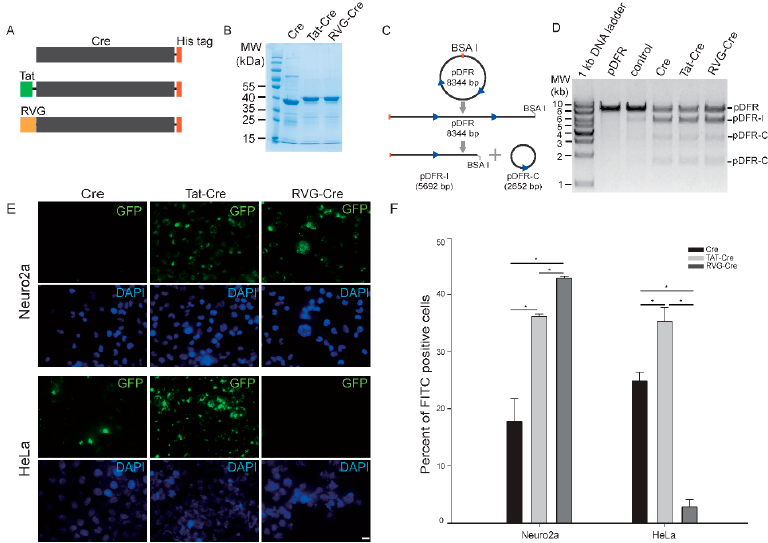
Figure 1. Purity, activity, and cell specificity of RVG-Cre, Tat-Cre, and wild-type (wt) Cre. ( A ) Schematics of three Cre proteins with a His tag at the C-terminus; ( B ) SDS-PAGE assay for purity of RVG-Cre, Tat-Cre, and wt Cre proteins; ( C ) Schematics of linearized pDFR plasmid after RVG-Cre-, Tat-Cre-, or wt Cre-mediated recombination. pDFR plasmid contains two loxP sites (blue arrowheads). After Cre-mediated recombination, pDFR is cleaved into a 5692 bp linearized fragment (pDFR-I) and a 2652 bp plasmid (pDFR-C); ( D ) Agarose gel electrophoresis of linearized pDFR recombined by RVG-Cre, Tat-Cre, or wt Cre. The two bands of pDFR-C represent nicked and supercoiled conformations of a circular plasmid, respectively; ( E ) Cell penetration of FITC-labeled RVG-Cre, Tat-Cre, or wt Cre in Neuro2a versus HeLa cells where 5 × 10 5 Neuro2a cells and 5 × 10 5 HeLa cells were plated in a 48-well plate, and cultured at 5% CO 2 overnight, followed by treatment with 1 µM FITC-labeled RVG-Cre, Tat-Cre, or wt Cre protein; Scale bar: 100 µM. ( F ) Percent of FITC positive cells treated with FITC-labeled RVG-Cre, Tat-Cre, or Cre proteins. All data are represented as mean ± S.D., n = 3. One way ANOVA was used for statistics. * p < 0.01.